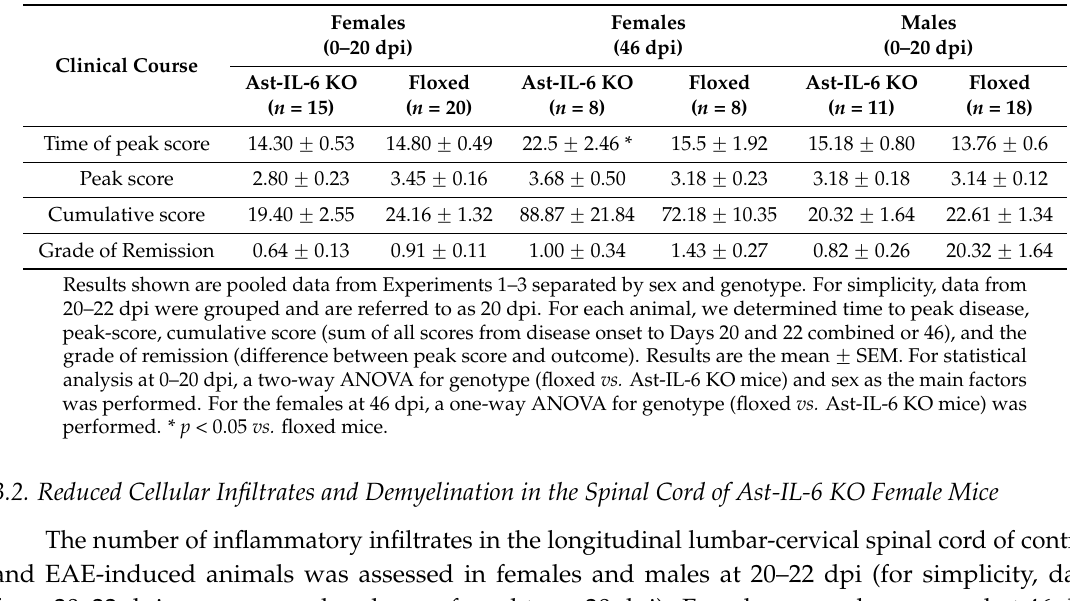
Table 3. EAE clinical